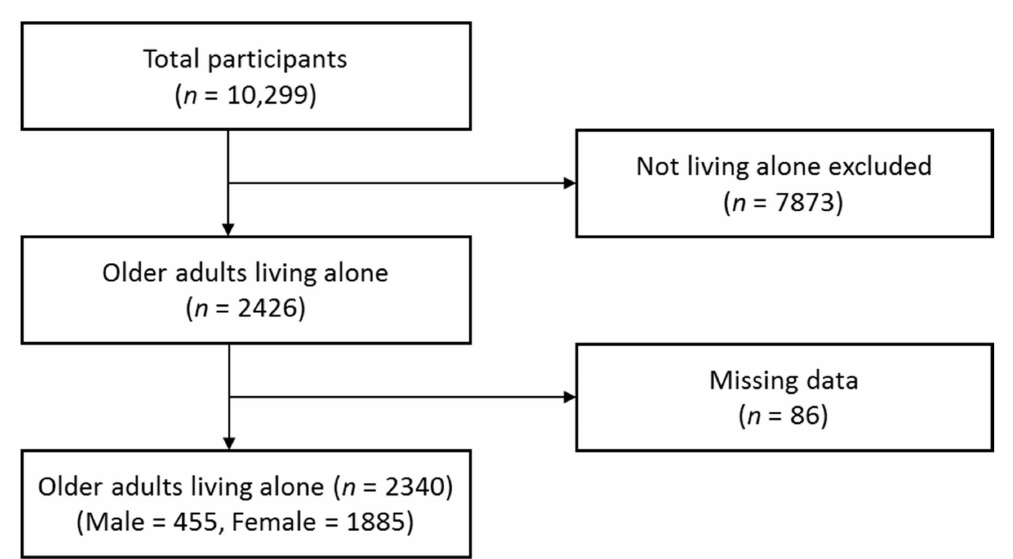
Figure 1. Flow chart of